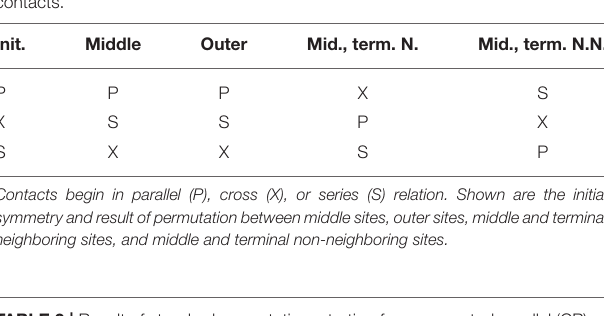
TABLE 2 | Result of standard permutation, starting from concerted parallel (CP) or concerted series (CS) relations. Init.